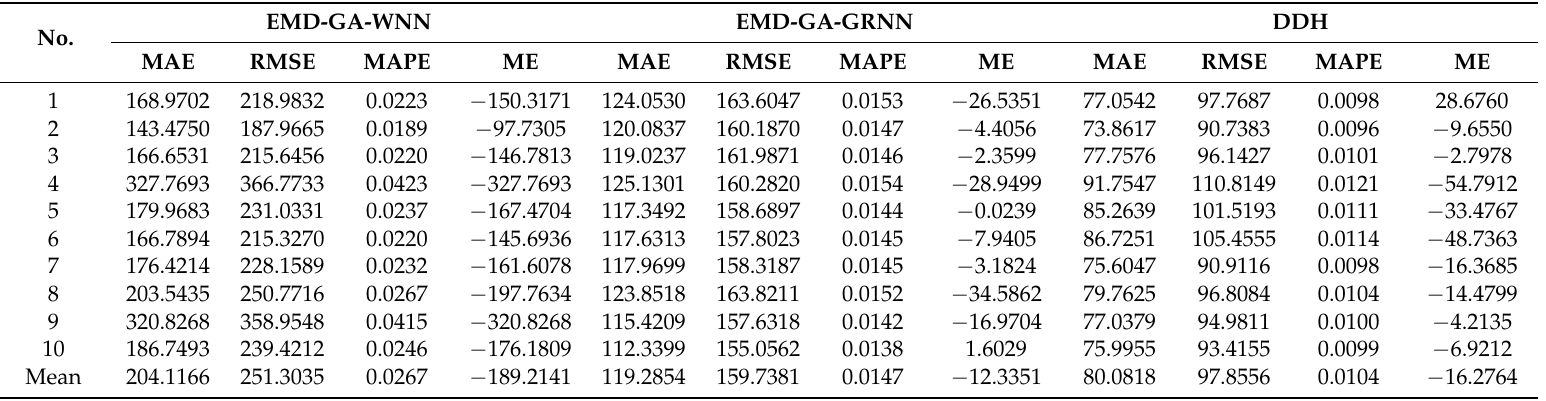
Table 3. Forecasting performance evaluation